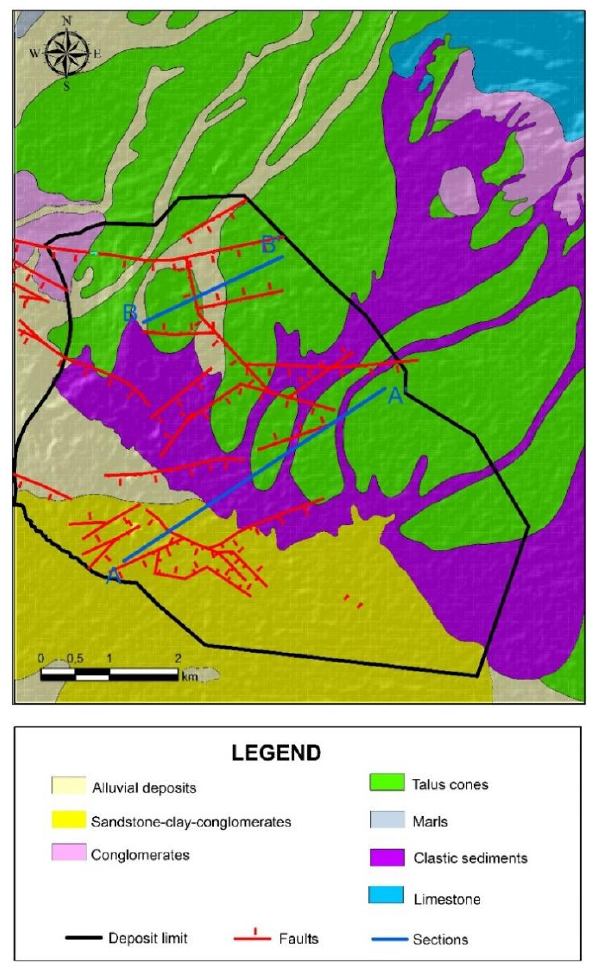
Figure 2. Geological setting of the South Field Mine, included the location of cross-sections (A–A’ and B –B’) .